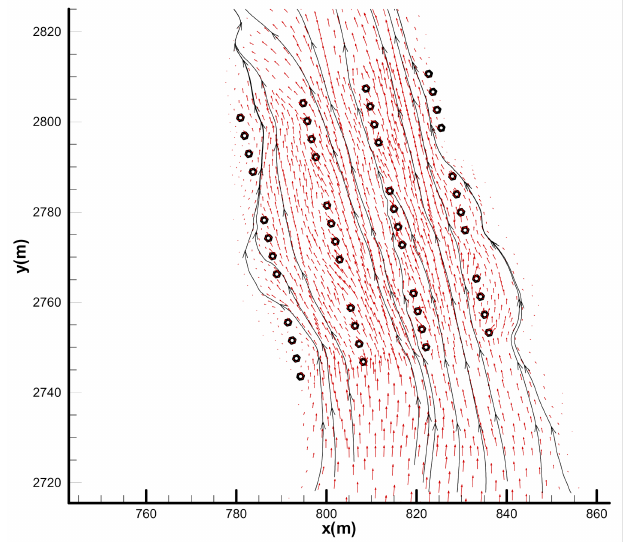
Figure 18. The velocity vectors and the contours of streamlines at the B1 bridge (t = 1100